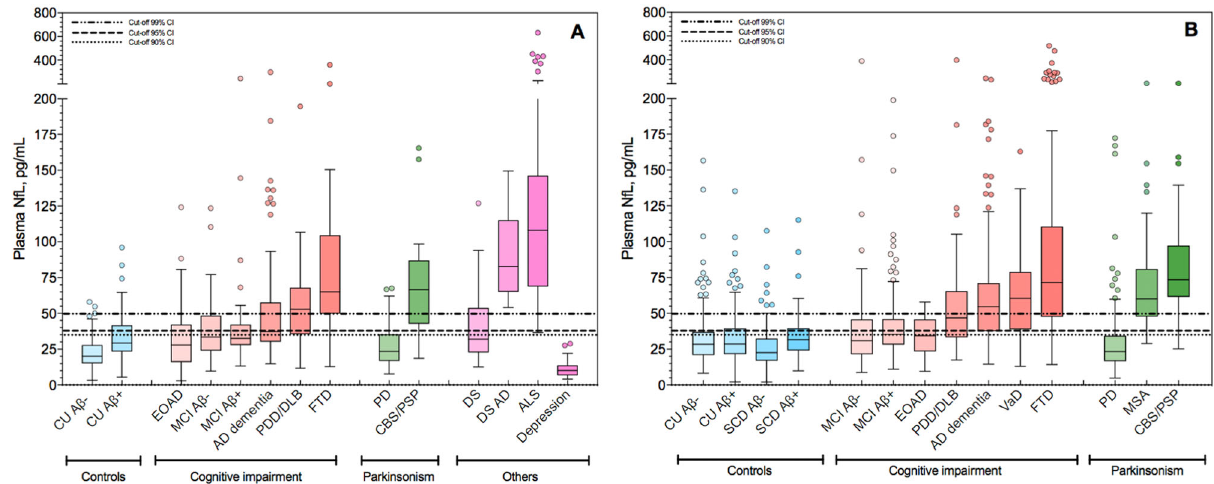
Fig. 1 The concentrations of plasma NfL for different diagnostic and controls groups in the KCL and Lund cohorts. Plasma neuro fi lament light (NfL) in different diagnostic groups; KCL ( A n = 805) and Lund ( B n = 1464) cohorts. For each plot, the horizontal bar shows the median, and the upper and lower boundaries show the 25th and 75th percentiles, respectively. Source data are provided as a Source Data fi le. KCL Cohort — AD Alzheimer ’ s disease ( n = 102), ALS amyotrophic lateral sclerosis ( n = 50), CU A β − cognitively unimpaired without A β pathology ( n = 130), CU A β + cognitively unimpaired with A β pathology ( n = 28), CBS/PSP corticobasal syndrome and progressive supranuclear palsy ( n = 19), depression ( n = 37), DS Down syndrome ( n = 29), DSAD Down syndrome Alzheimer ’ s disease ( n = 12), EOAD early-onset Alzheimer ’ s disease ( n = 59), FTD frontotemporal dementia ( n = 54), MCI A β − mild cognitive impairment without A β pathology ( n = 55), MCI A β + mild cognitive impairment with A β pathology ( n = 31), PD Parkinson ’ s disease ( n = 140), PDD/DLB Parkinson ’ s disease dementia and dementia with Lewy bodies ( n = 59). Lund Cohort — AD Alzheimer ’ s disease ( n = 134), CU A β − cognitively unimpaired without A β pathology ( n = 273), CU A β + cognitively unimpaired with A β pathology ( n = 103), CBS/PSP corticobasal syndrome and progressive supranuclear palsy ( n = 24), EOAD early-onset Alzheimer ’ s disease ( n = 23), FTD frontotemporal dementia ( n = 150), MCI A β − mild cognitive impairment without A β pathology ( n = 115), MCI A β + mild cognitive impairment with A β pathology ( n = 165), MSA multiple system atrophy ( n = 29), PD Parkinson ’ s disease ( n = 171), PDD/DLB Parkinson ’ s disease dementia and dementia with Lewy bodies ( n = 46), SCD A β −